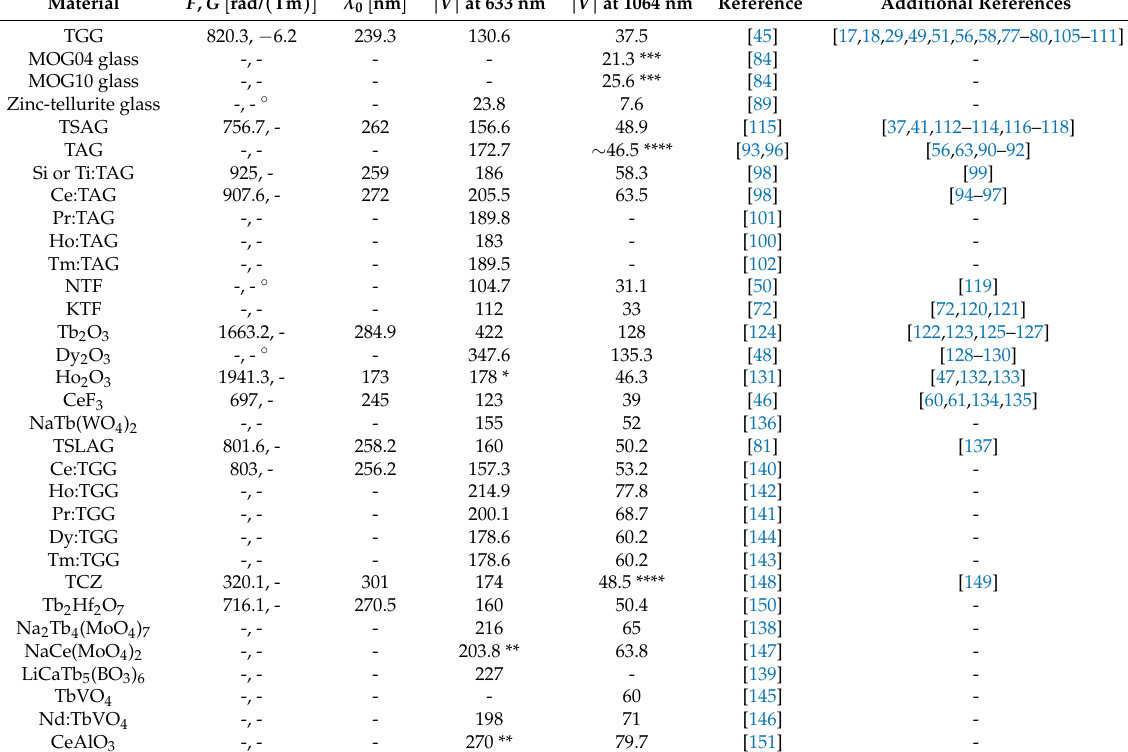
Table 2. A brief overview of magneto-active materials for the VIS-NIR FDs (400 < λ < 1100 nm). The Verdet constant dispersion V ( λ ) is given by the single-transition model in Equation (13) with the specified ( F , G , λ 0 )-parameters. The listed V -values are the absolute values of the Verdet constant, specified in rad/ ( Tm ) . Some of the listed values were measured * at 600 nm, ** at 635 nm, *** at 1060 nm or **** at 1075 nm. ◦ A function different from the model in Equation (13) for the Verdet constant dispersion may be found in the listed reference.